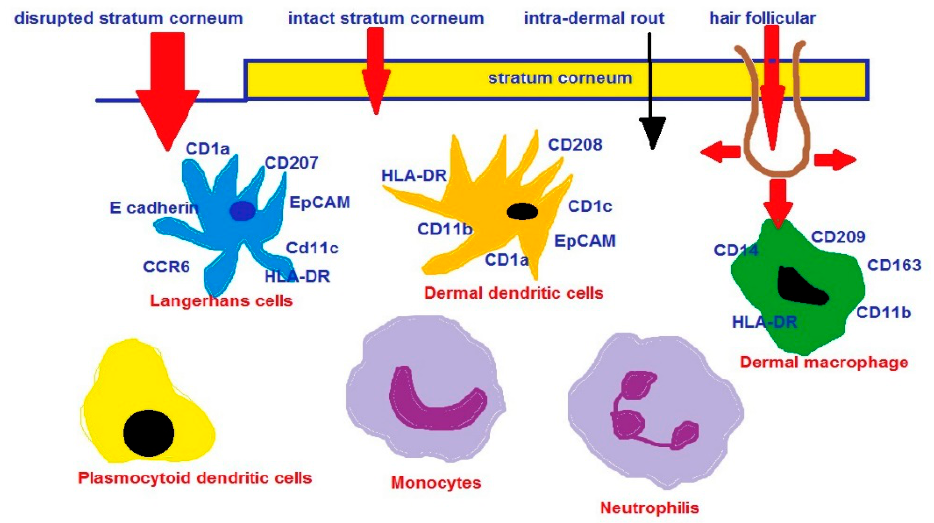
Figure 3. Skin penetration routes of NP-based vaccines together with subpopulations of APC (antigen-presenting cells).